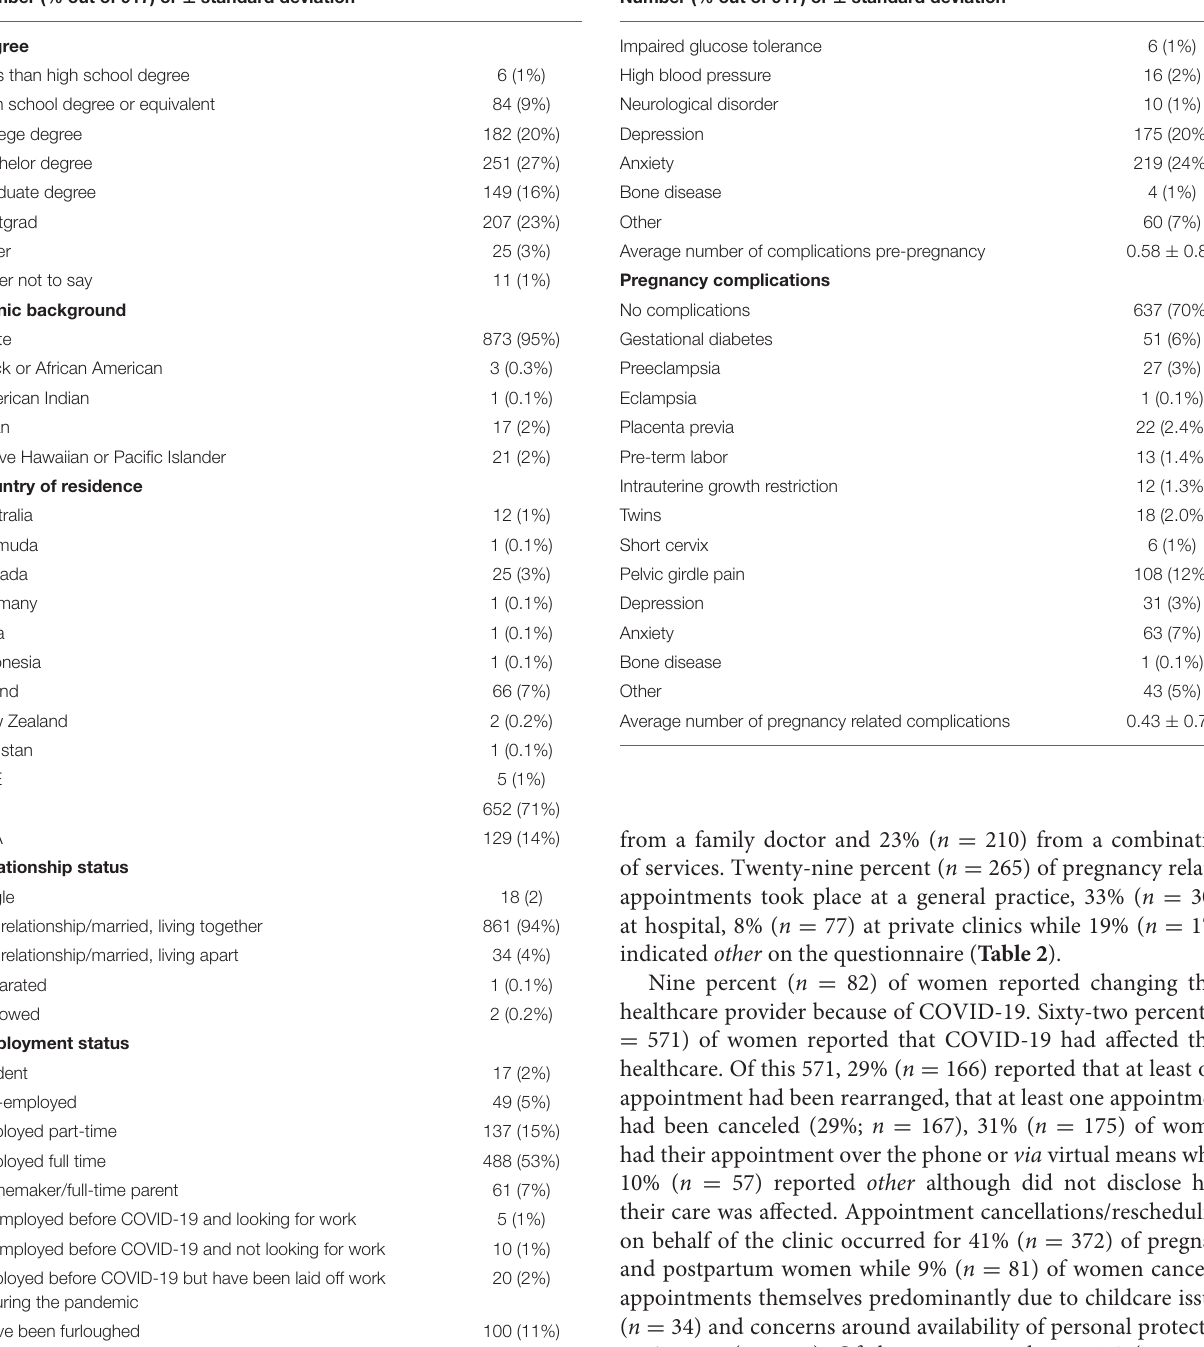
TABLE 1 | Participant